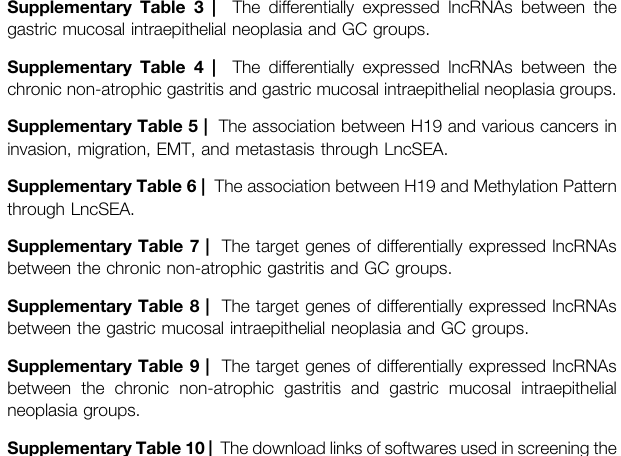
Supplementary Table 5 | The association between H19 and various cancers in invasion, migration, EMT, and metastasis through LncSEA. Supplementary Table 6 | The association between H19 and Methylation Pattern through LncSEA.